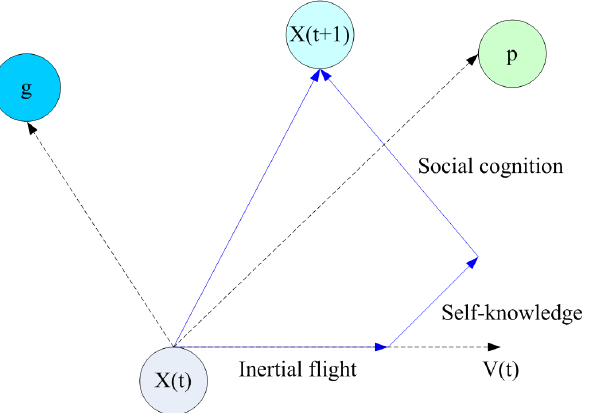
Figure 2. Particle renewal